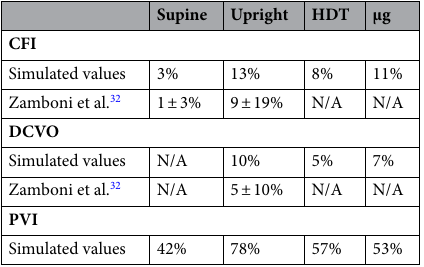
Table 3. Simulated and literature mean indexes. HDT head-down tilt, μg microgravity, CFI collateral flow index, DCVO delta cerebral venous outflow, PVI peripheral veins outflow